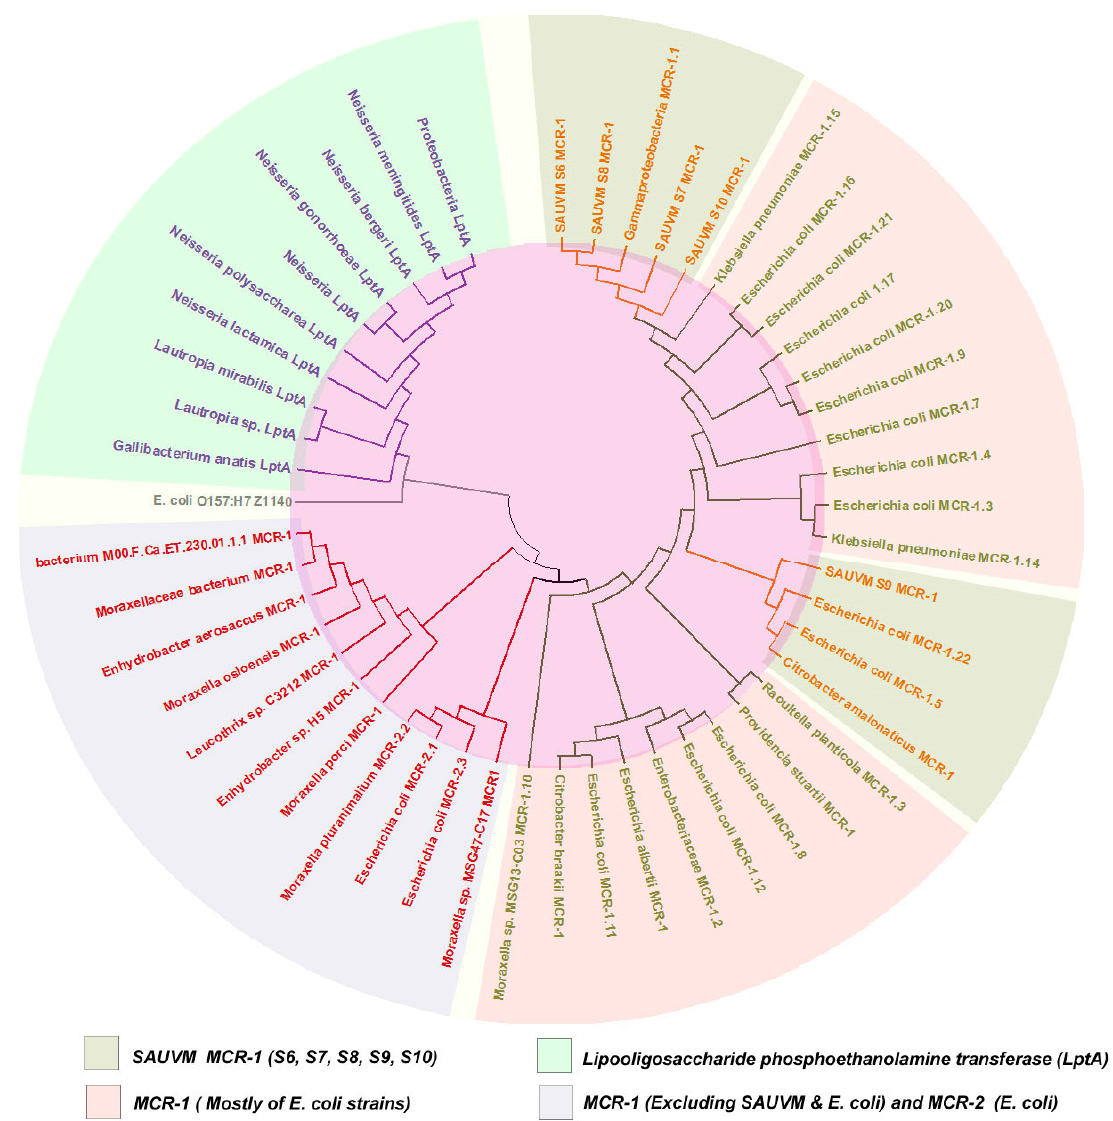
Figure 3. Phylogeny analysis showing ancestral origin and diversification of MCR-1 and MCR-1 like proteins. The BLAST search tool ( https://blast.ncbi.nlm.nih.gov/Blast.cgi ) was used to retrieve the homologous sequences of the MCR-1 and